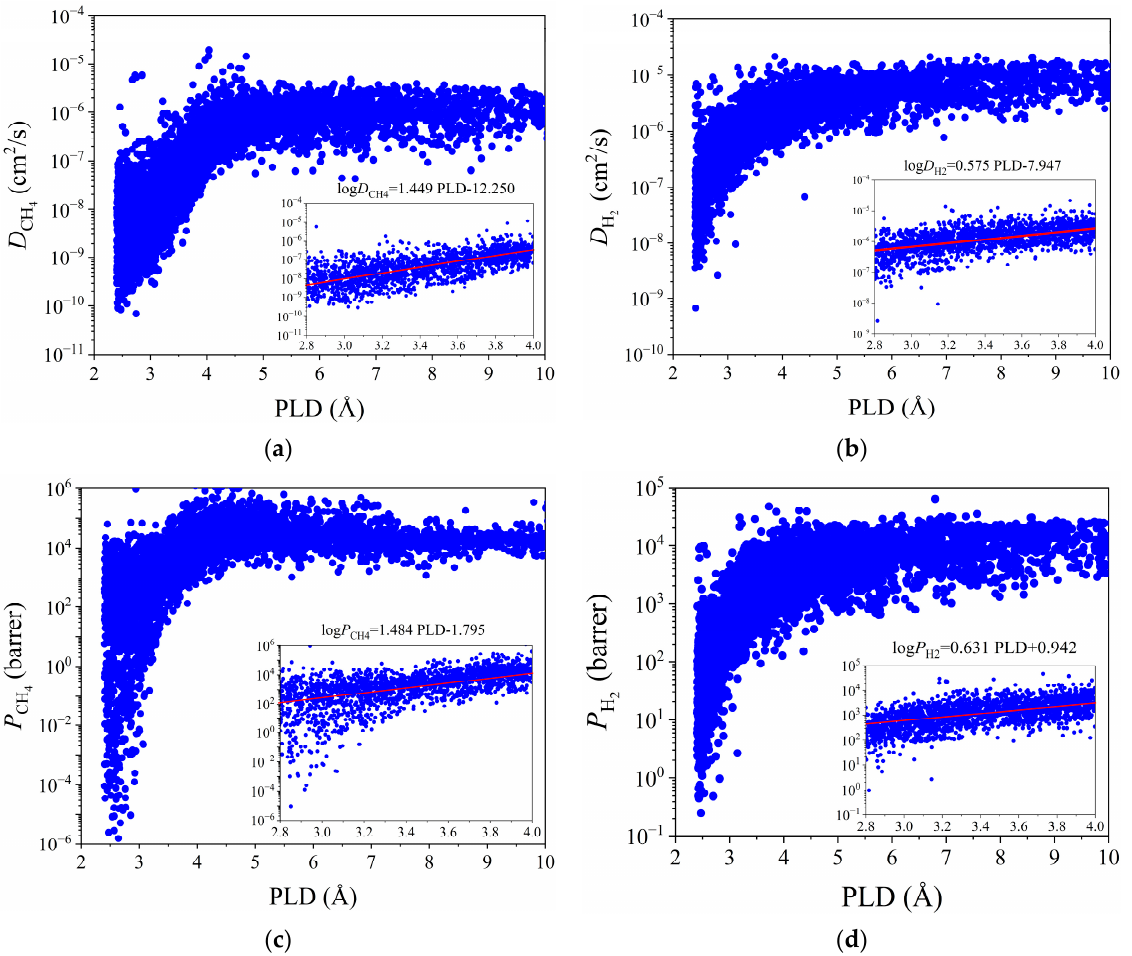
Figure 2. Diffusion coefficient D and permeability P vs. PLD for CH 4 and H 2 in 6013 CoRE-MOFs: ( a ) D CH4 –PLD; ( b ) D H2 –PLD; ( c ) P CH4 –PLD; ( d ) P H2 –PLD.